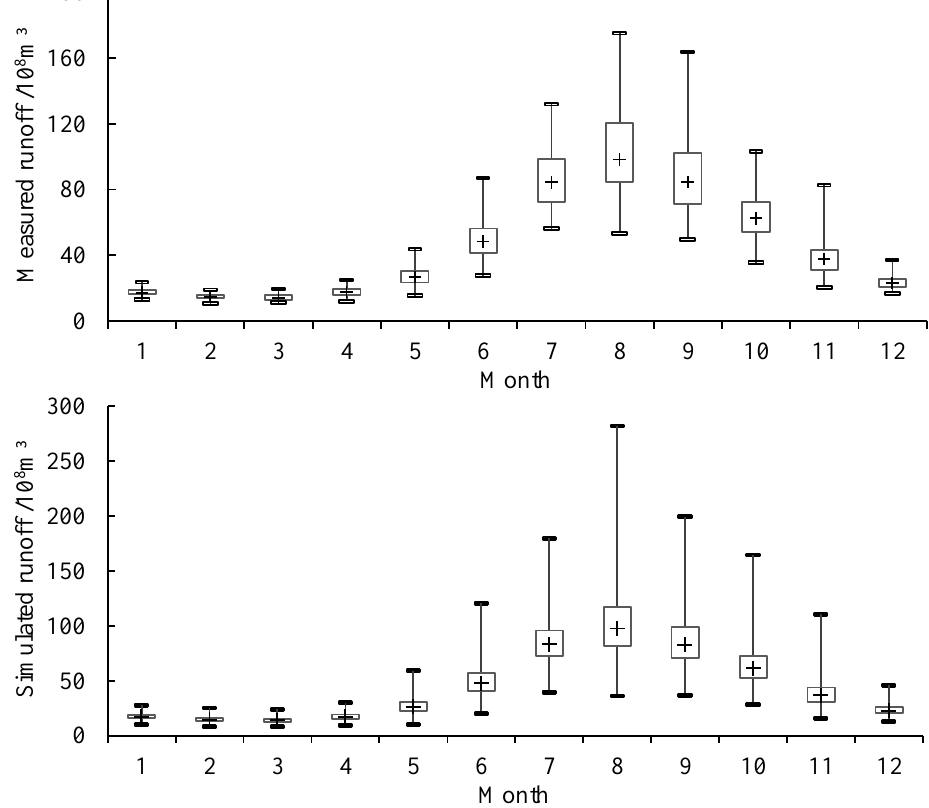
Figure 6. Observed and simulated monthly inflow of the NZD hydropower plant.